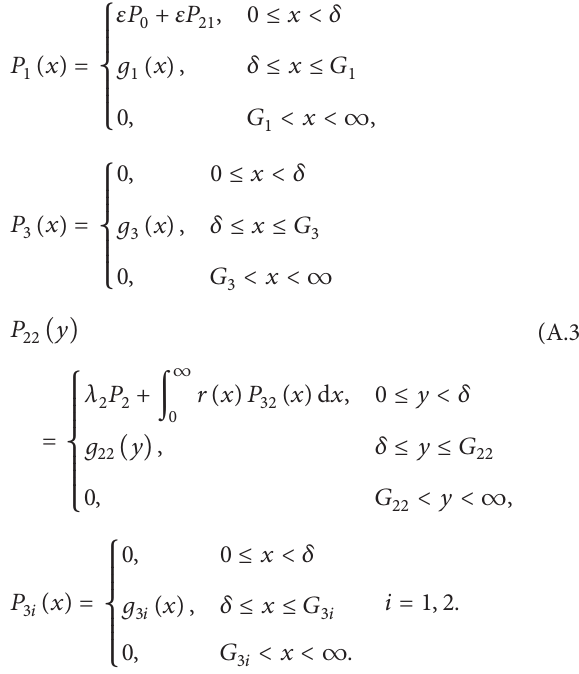
Figure 8: Profit difference of systems with and without warning device with 𝛼 0 = 0 .